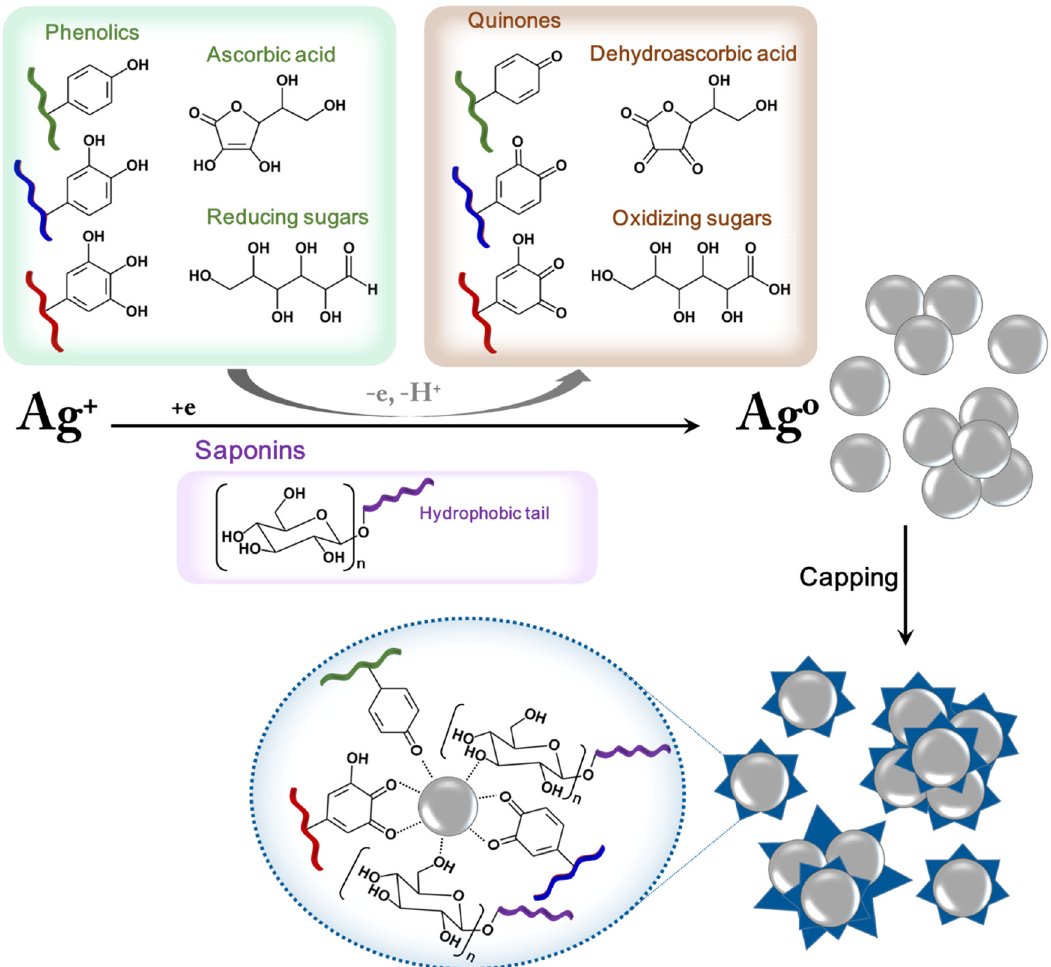
Figure 4: The reaction mechanism to form biogenic AgNPs and the possible linkages between AgNPs and natural compounds for AgNP